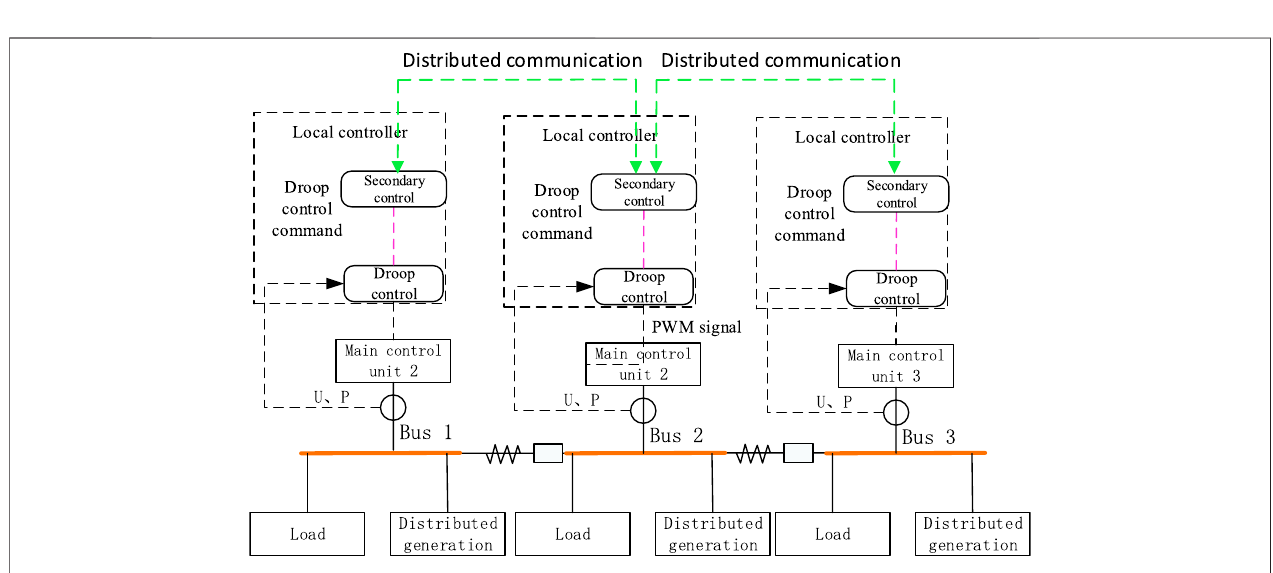
FIGURE 7 | Schematic diagram of distributed cooperative control